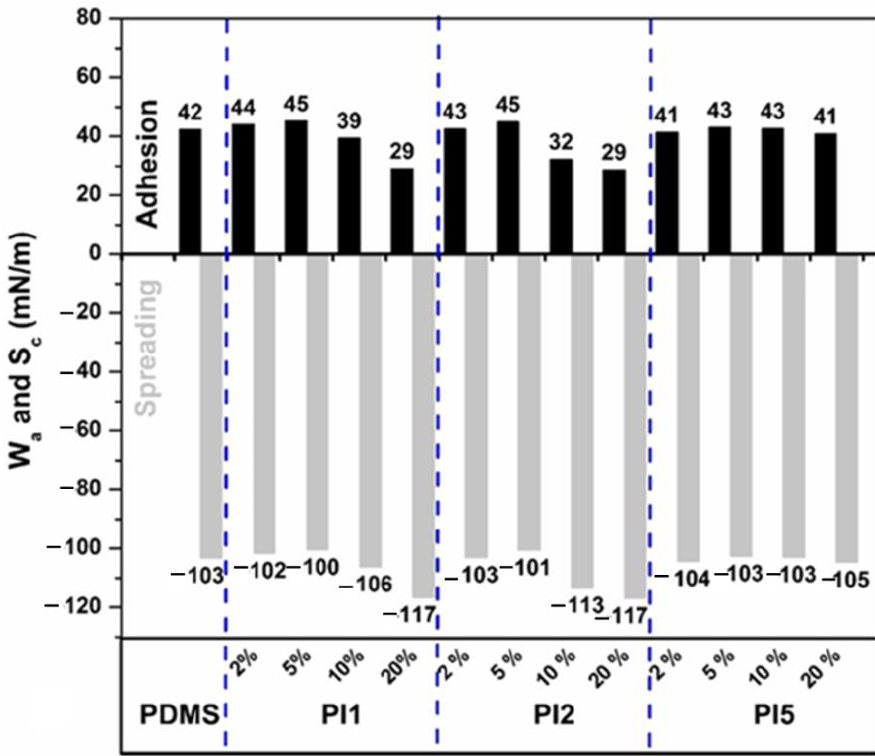
Figure 3. Work of adhesion and spreading coefficient of the composite films.